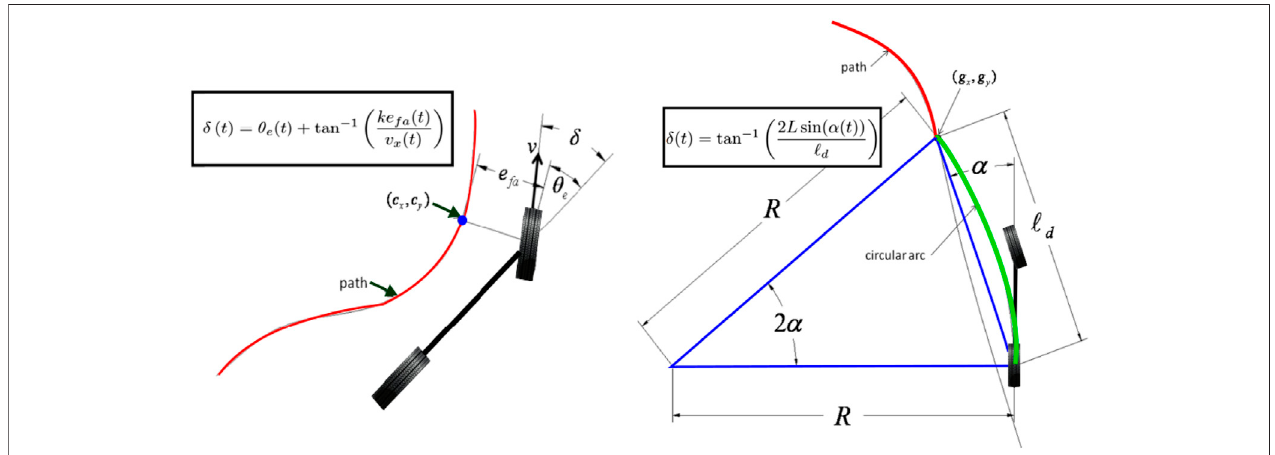
FIGURE 4 | Stanley (left) and pure pursuit (right) controller schematic diagrams (recreated from the schematic diagrams in Sinder, 2009).